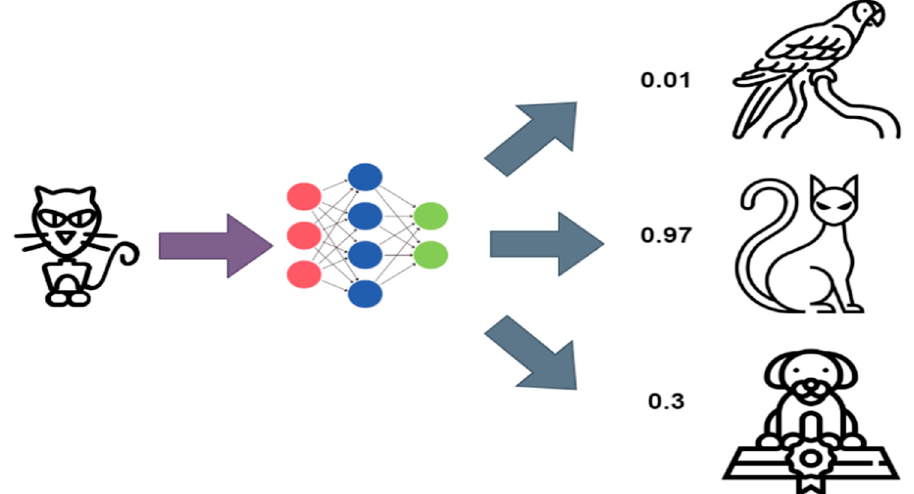
Figure 2. An illustrative example of learning dark knowledge through a knowledgeable teacher model in image classification problems. In this example, although we know that the input image falls in the cat category, we also know that the input has a higher probability of falling into the dog category than into the bird category. The pre-described classi fi cation order is the so-called “inter-class relationship”.